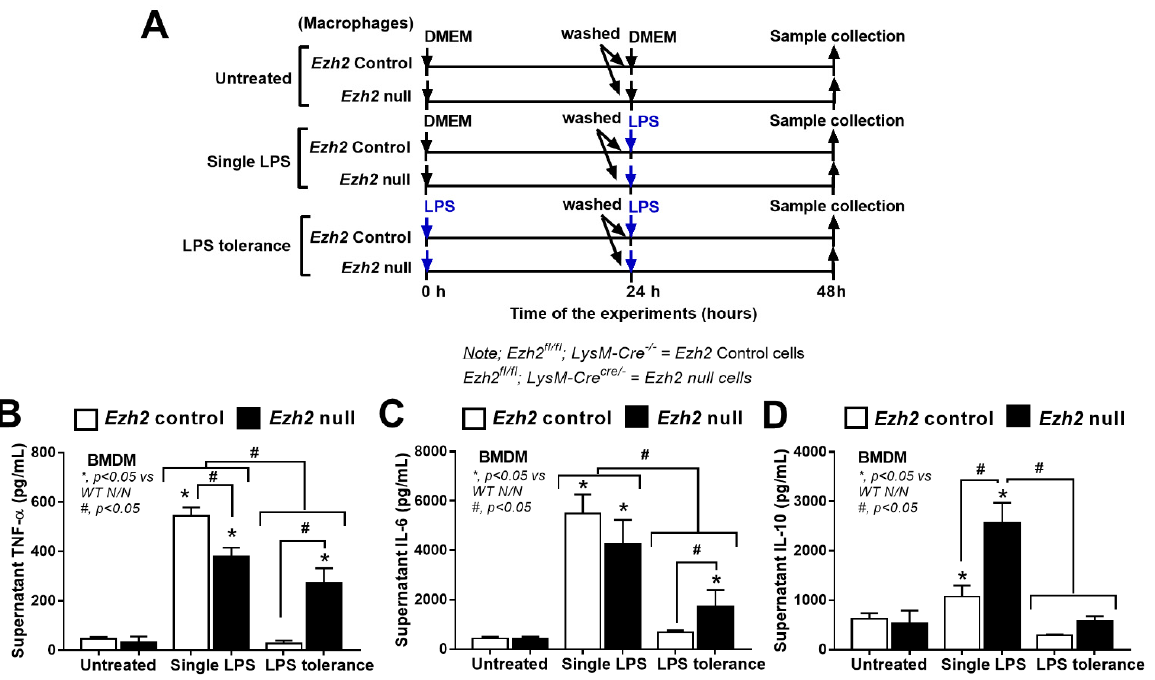
Figure 3. The schema of the experiments in bone-marrow-derived macrophages from Ezh2 control ( Ezh fl/fl ; LysM-Cre − / − ) or Ezh2 null ( Ezh fl/fl ; LysM-Cre cre/ − ) mice after activation by lipopolysaccharide